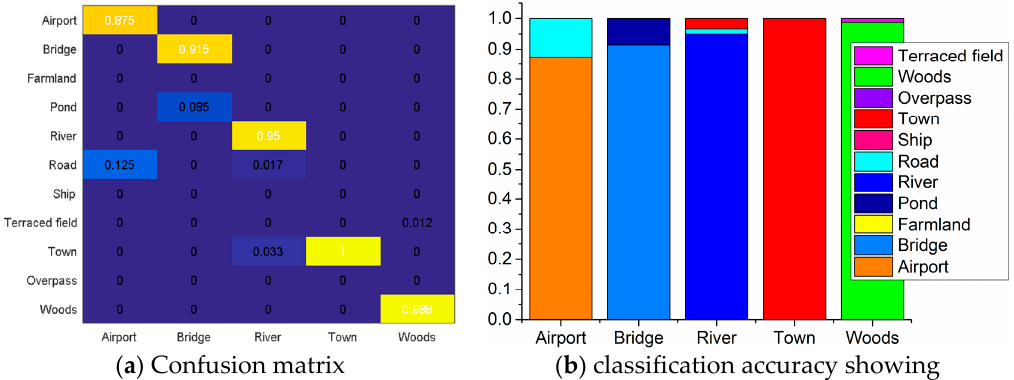
Figure 14. The classification results for the five types of